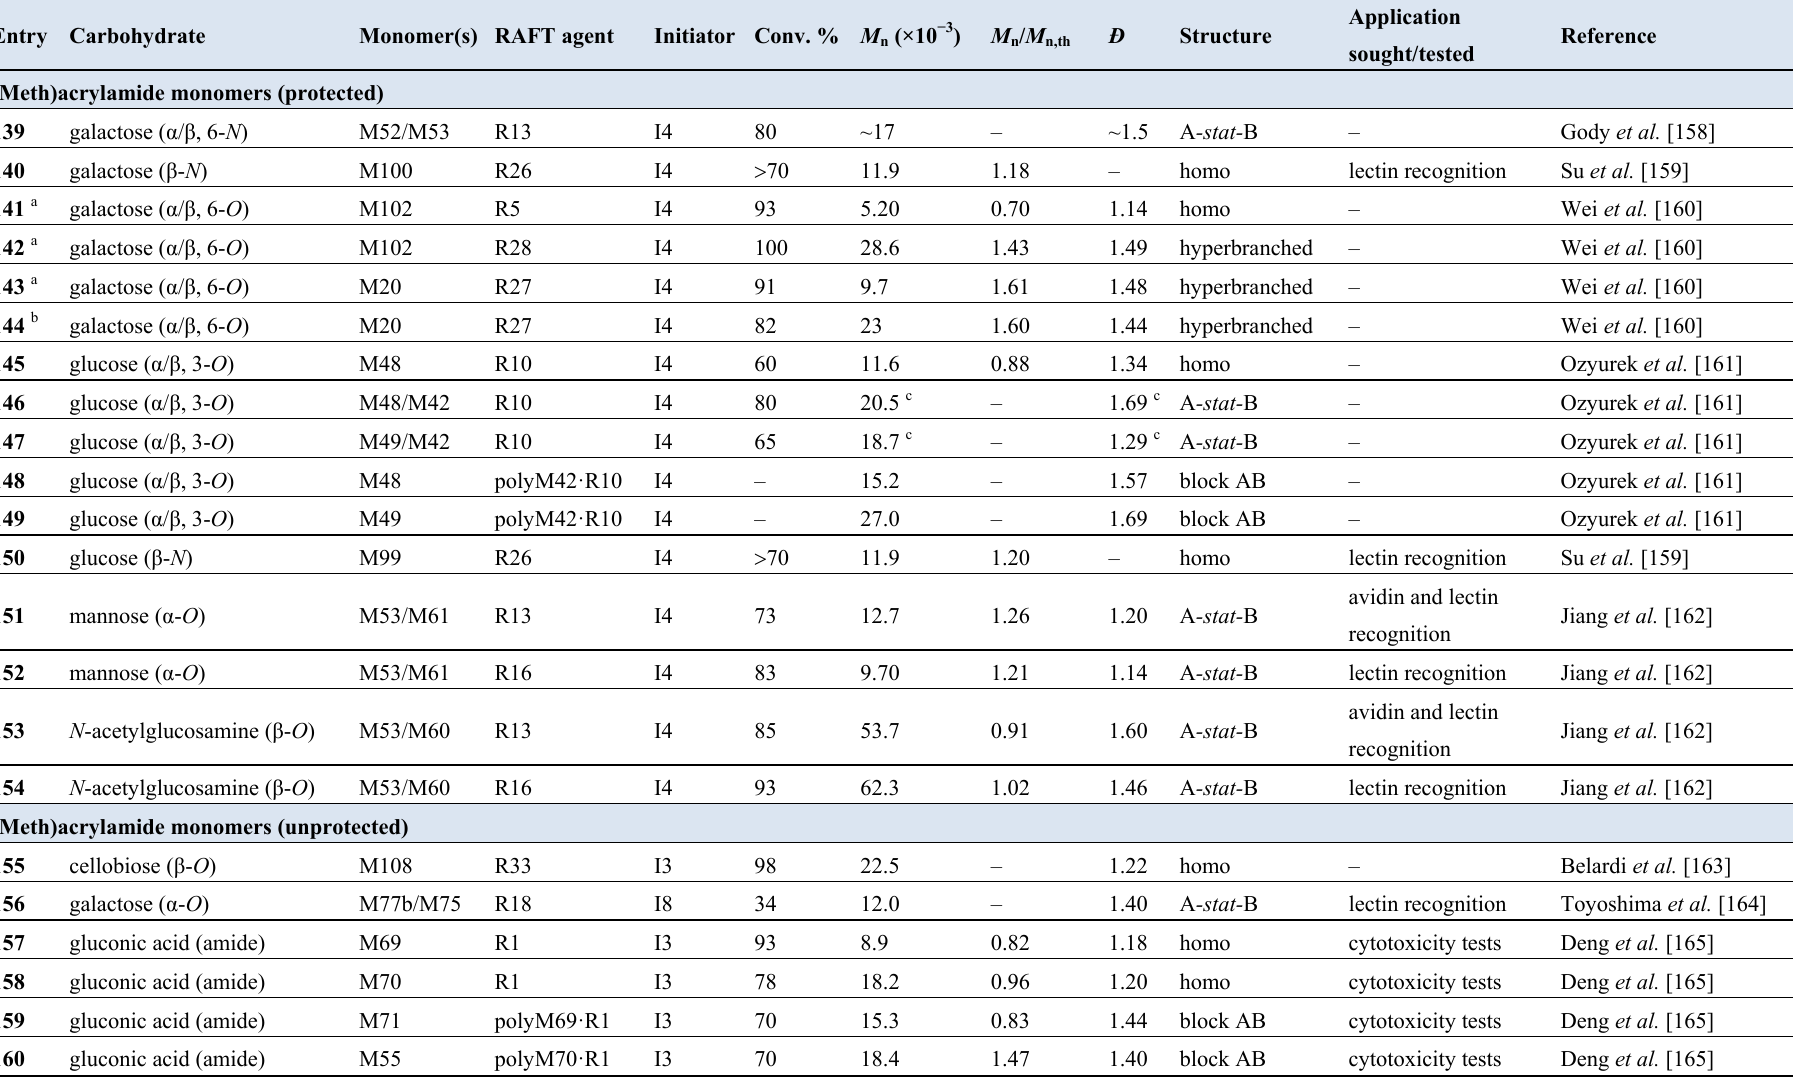
Table 3. Glycopolymers by reversible addition-fragmentation chain transfer (RAFT)